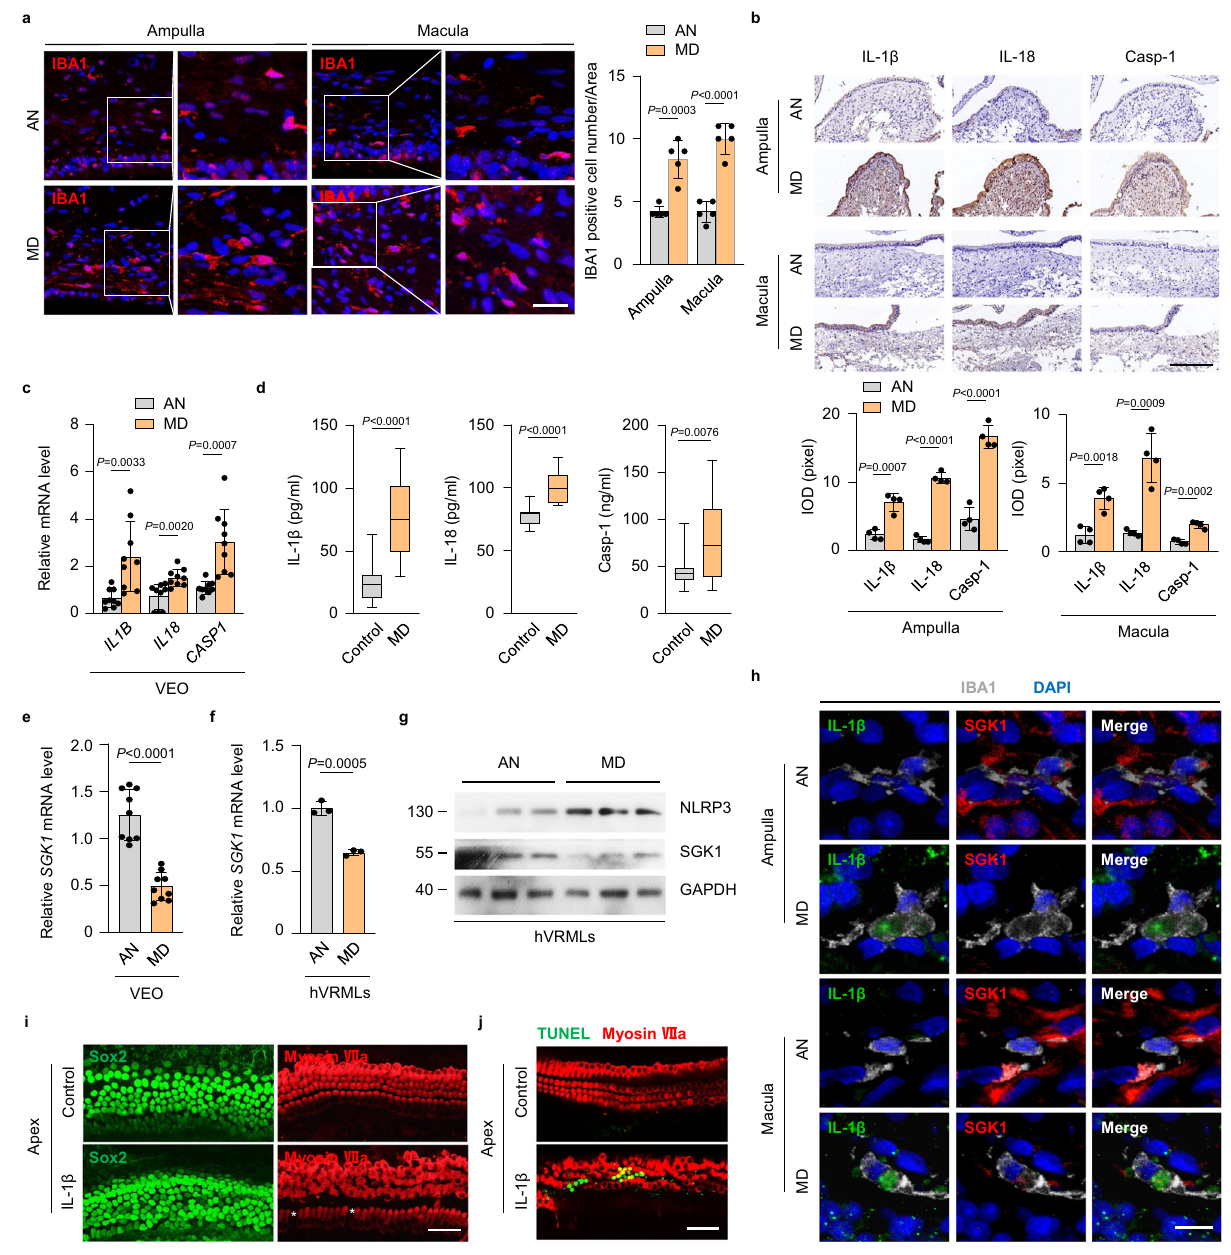
Fig. 1 | Decrease in SGK1 expression is associated with in fl ammasome activa- tion in VRML cells from MD patients. a Representative confocal microscopy imagesshowingIBA1(red)andDAPI(blue)stainingintheampullaandmaculaofAN ( n =5)andMDpatients( n =5).Analysisofimagesisshownontheright,quantifying the number of IBA1-positive cells per area. The right panels represent 2-fold enlargements of the white-boxed areas in the left panels. Scale bar = 25 μ m. b Representative images of immunohistochemical staining and densitometric quanti fi cationofIL-1 β ,IL-18,andCasp-1intheampullaandmaculaofAN( n =4)and MD patients ( n =4), scale bar = 100 μ m. c Quantitative real-time PCR analysis of IL1B,IL18 ,and CASP1 mRNAinVEOofAN( n =9)andMDpatients( n =9). d ELISAof plasma IL-1 β , IL-18, and Casp-1 levels in controls ( n =20) and MD patients ( n =20). e Quantitative real-time PCR analysis of SGK1 mRNA in VEO of AN ( n =9) and MD patients( n =9). f Quantitativereal-timePCRanalysisof SGK1 mRNAinVRMLcellsof AN and MD patients ( n =3). g Representative images of western blotting detecting by macrophages affected the inner ear hair cells and vestibular neu- rons. We exposed the basilar membrane of all turns from the mouse cochlea to IL-1 β in vitro. Compared to the control group, cochlear hair cells (Myosin VIIa positive) exposed to IL-1 β showed disordered